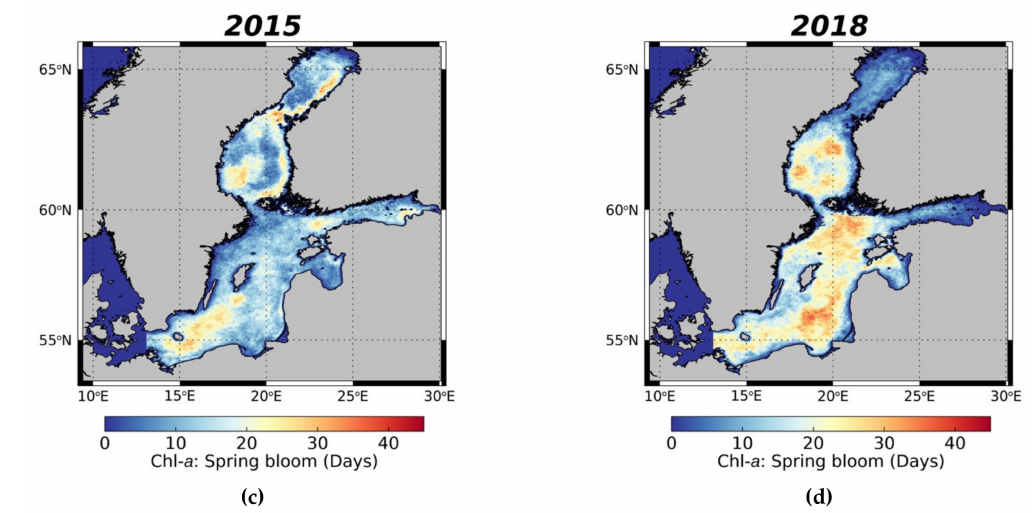
Figure 8. Spring bloom spatio-temporal coverage for the whole Baltic Sea. ( a ) 2007, ( b ) 2008, ( c ) 2015, and ( d ) 2018.